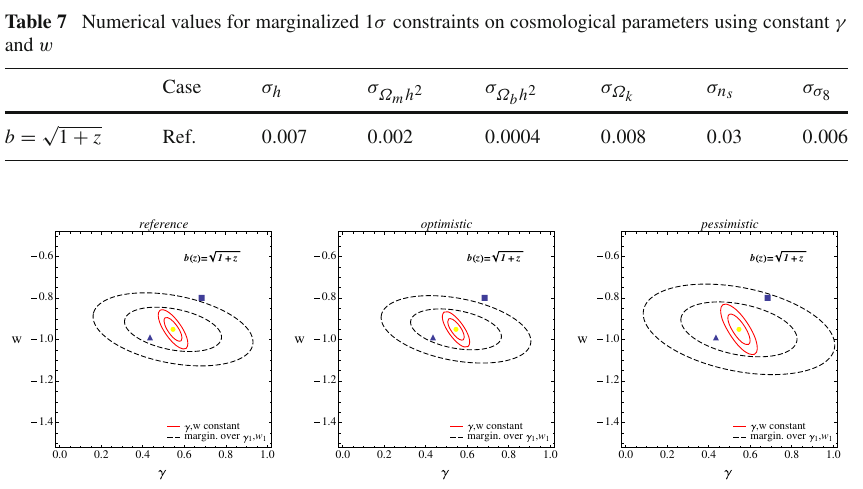
1 and σ γ , σ w of Table 8. Yellow marg , 1 marg , 1